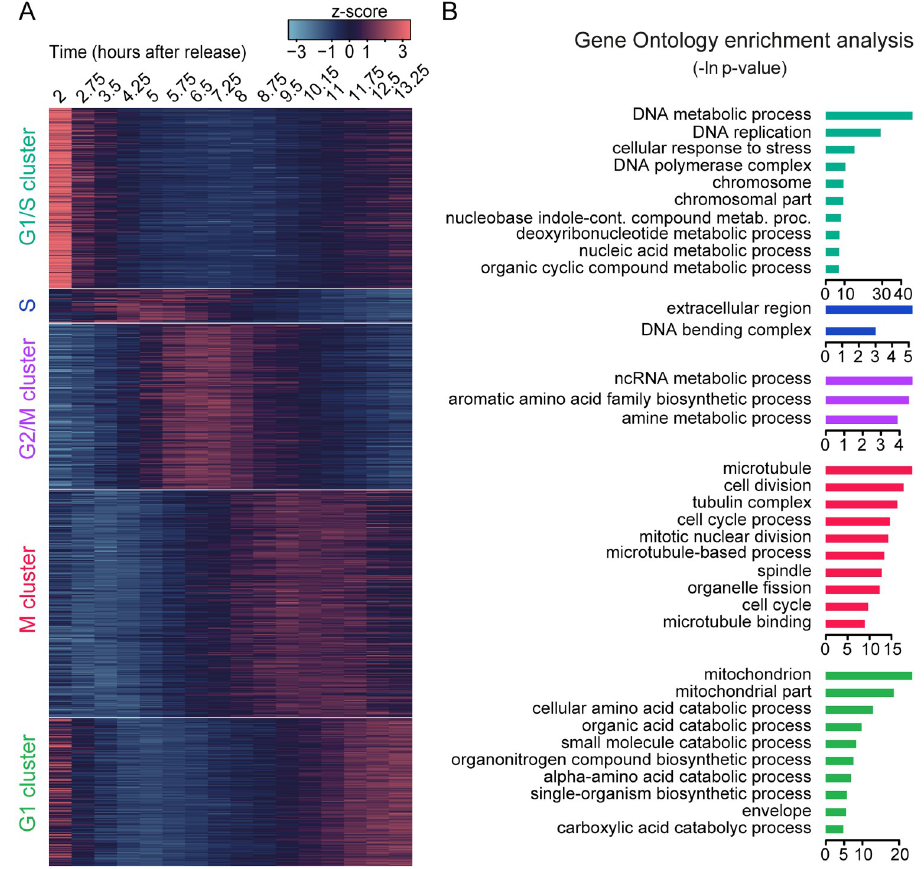
Fig 4. The periodic transcriptional program of Capsaspora . A : heatmap of gene expression level depicting the five main clusters detected by Euclidean distance hierarchical clustering. Clusters were rearranged to visually represent their expression peaks over time. B : Top ten enriched gene ontology terms for every cluster shown in A. We considered an enrichment as significant when Bonferroni corrected p-value was lower than 0.05. For the full list of enriched GO terms, see S6